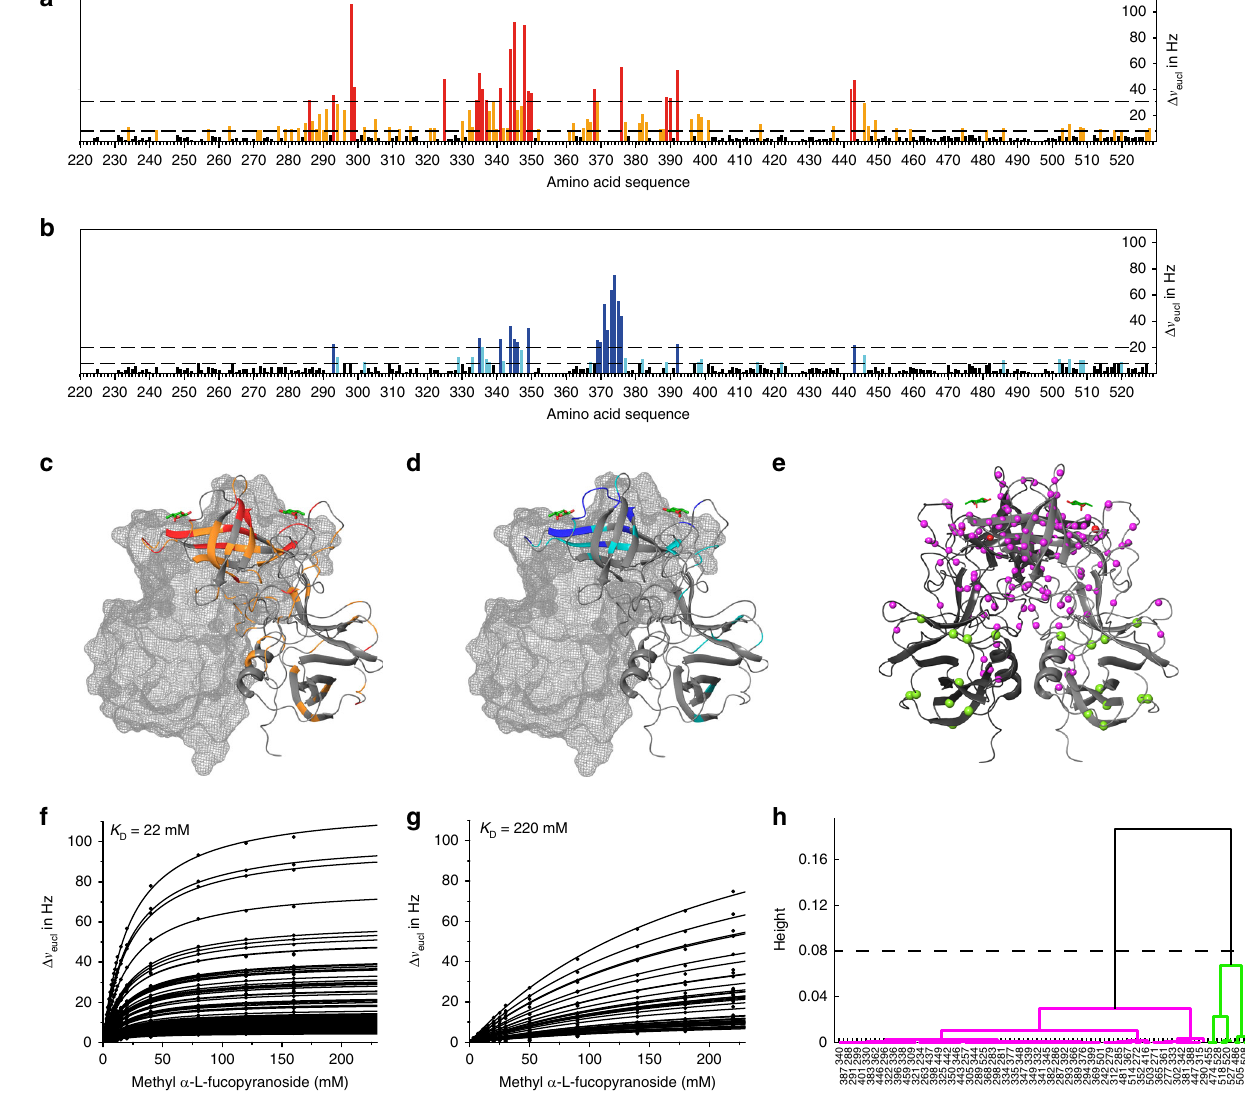
Fig. 4 Binding of methyl α - L -fucopyranoside to GII.4 Saga P-dimers. a , b Chemical shift perturbations (CSPs) of NH backbone signals of GII.4 Saga NN P- dimers ( a ) and iDiD P-dimers ( b ) in the presence of 160 and 220mM methyl α - L -fucopyranoside, respectively. Dashed lines are at 2 σ (red, blue) and at the experimentally determined signi fi cance threshold of 7.9 Hz (orange, light blue). c , d CSPs for NN ( c ) and iDiD P-dimers ( d ) mapped on the crystal structure (pdb: 4X06) of GII.4 Saga P-dimers. Color coding as in a and b . e Clusters of amino acids (N backbone atoms are shown as balls) of NN P-dimers re fl ecting two distinct types of binding isotherms (cf. Supplementary Note 2 and Supplementary Fig. 13). Color coding is as in h . f , g Global fi tting of the law of mass action to chemical shift titration curves of NN P-dimers for amino acids belonging to the magenta cluster ( f ) and for iDiD P-dimers ( g ). For details of the curve fi tting see Supplementary Note 2, Supplementary Equation 11, and Supplementary Table 8. The curves re fl ect one-site binding, and global fi tting yields dissociation constants of K D = 22 mM and of K D = 220 mM for NN and iDiD P-dimers, respectively. h Complete linkage clustering separating amino acids of NN P-dimers based on distinct shapes of binding isotherms into two clusters (magenta and green). Source data are provided as a Source Data fi